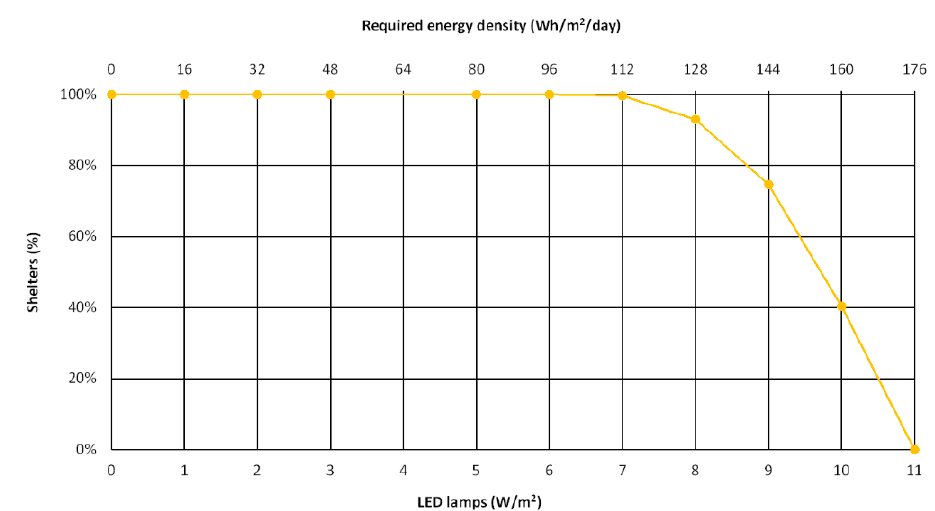
Figure 10. Evolution of the percentage of bus shelters according to LED power density and energy requirements.